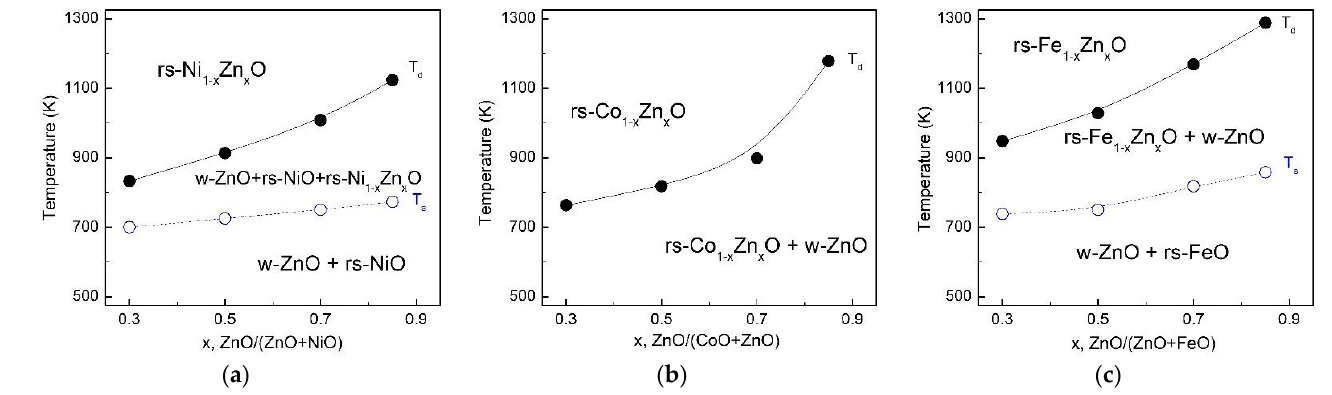
Figure 3. ( a ) The onset (T s ) and completion (T d ) temperatures of chemical interaction in the NiO-ZnO ( a ), CoO-ZnO ( b ) and FeO-ZnO ( c ) systems versus stoichiometry at 4.9 GPa [40,42,43]. Open circles show the temperatures when lines of cubic solid solution appear in the diffraction patterns while solid circles correspond to the temperatures when lines of wurtzite ZnO disappear completely.